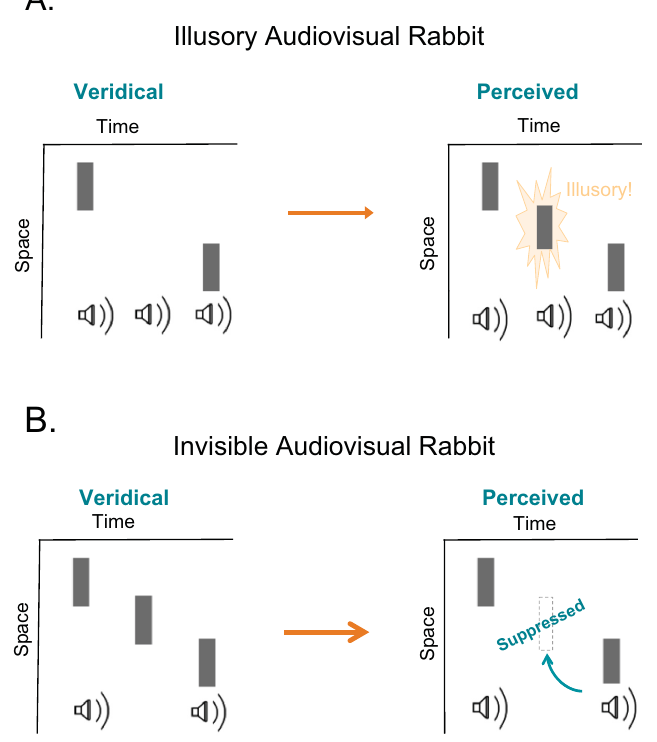
Fig 1. Space-time diagrams of the illusory and invisible AV Rabbits. Plots of space and time dimensions indicate the approximate timing and location of the flashes and beeps presented in the Illusory and Invisible AV Rabbits. The veridical plot indicates the physical stimulus presented to the participants, and the perceived plot indicates the stimulus that participants report seeing and hearing. Vertical bars represent visual flashes, and speaker icons represent sounds.